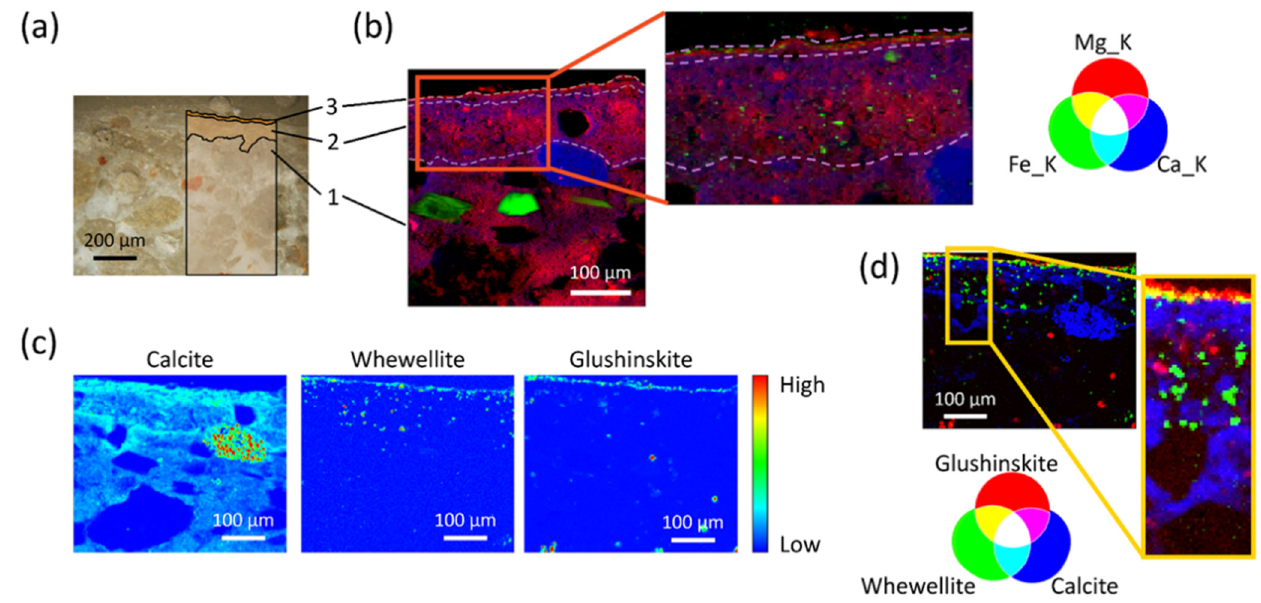
Figure 6. Analysis of the interactions of inorganic-mineral conservation treatments (AmOx) with Mg-containing frescos by a combination of µXRPD and µXRF mapping carried out at ID13 and at ID21, respectively. ( a ) Optical image of the fresco stratigraphy in cross-section: (1) plaster, (2) intonachino , (3) ~10 µm external portion of intonachino with iron-based pigments. The investigated ROI was about ~500 × 400 µm 2 at ID13 and ~ 400 × 400 µm 2 at ID21. ( b ) RGB correlation of µXRF distribution maps of calcium (Ca K), magnesium (Mg K) and iron (Fe K). The inset highlights the presence of iron-based pigments in the external portion of the intonachino ; ( c ) µ XRPD distribution maps of calcite, whewellite and glushinskite presented in a colourmap spanning from low (blue) to high (red) values of relative intensity; ( d ) RGB correlation of the µ XRPD distribution maps of calcite, whewellite and